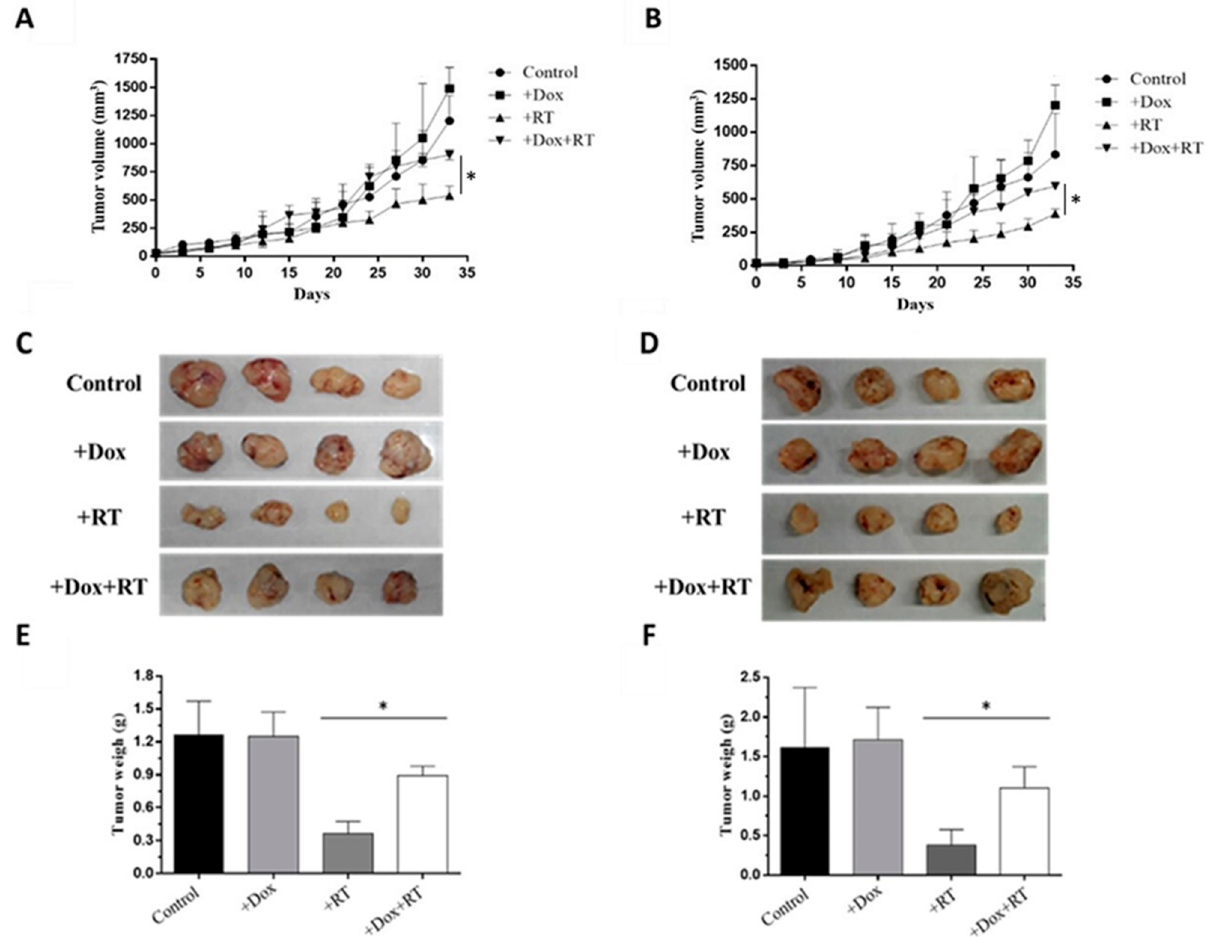
Figure 6. ERCC1 overexpression reduced RT-therapeutic efficiency. A xenograft model was divided into four groups: control, +Dox (treated with doxycycline), +RT (exposed to radiation), and +Dox +RT (treated with doxycycline and exposed to radiation). Tumor volumes were measured between days 0 and 33 in ( A ) HCT116-Tet-on ERCC1 and ( B ) COLO205-Tet-on-ERCC1 cells. ( C ) HCT116 ( D ) and COLO 205 tumors were collected and weighed on day 33. Respective weight data are shown as subfigures ( E , F ) ( p < 0.05 *).